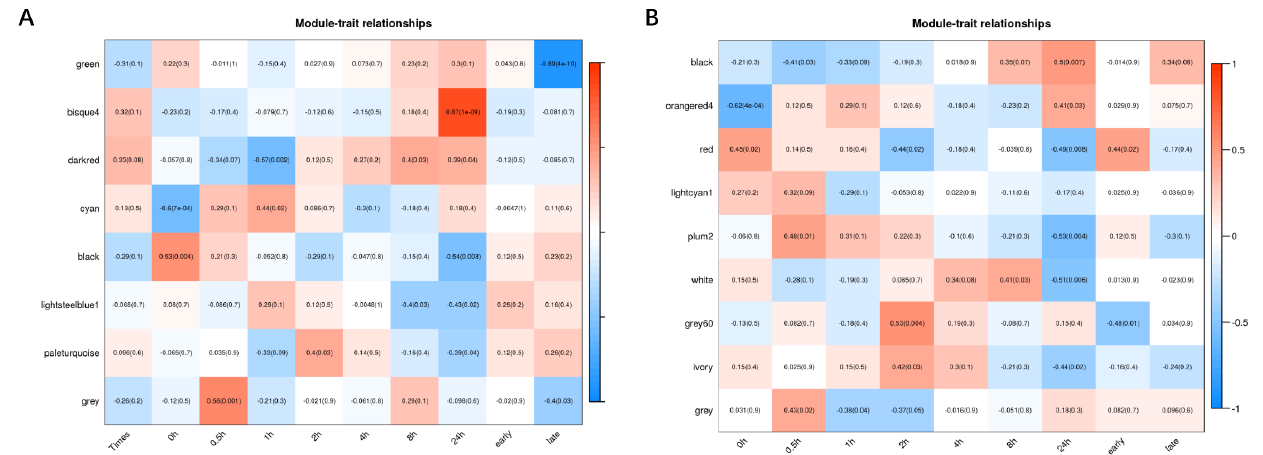
Figure 3. The correlation coefficient and correlation significance between the module and different time points of HS in IR64 ( A ) and Koshihikari ( B ). Each row in the table corresponds to a consensus module, and each column to a time point. The module name is shown on the y -axis, and the time point is shown on the x -axis. The table is color coded by correlation according to the color legend. Intensity and direction of correlations are indicated on the right side of the heatmap (red, positively correlated; blue, negatively correlated).